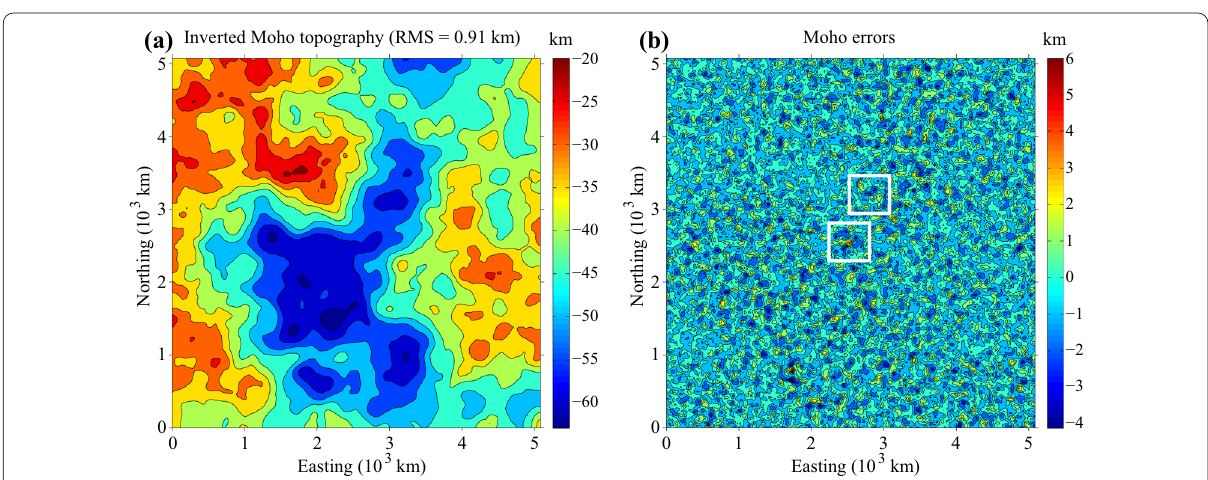
Fig. 10 a Inverted Moho topography with the forward‑modelled Bouguer anomaly. b Moho